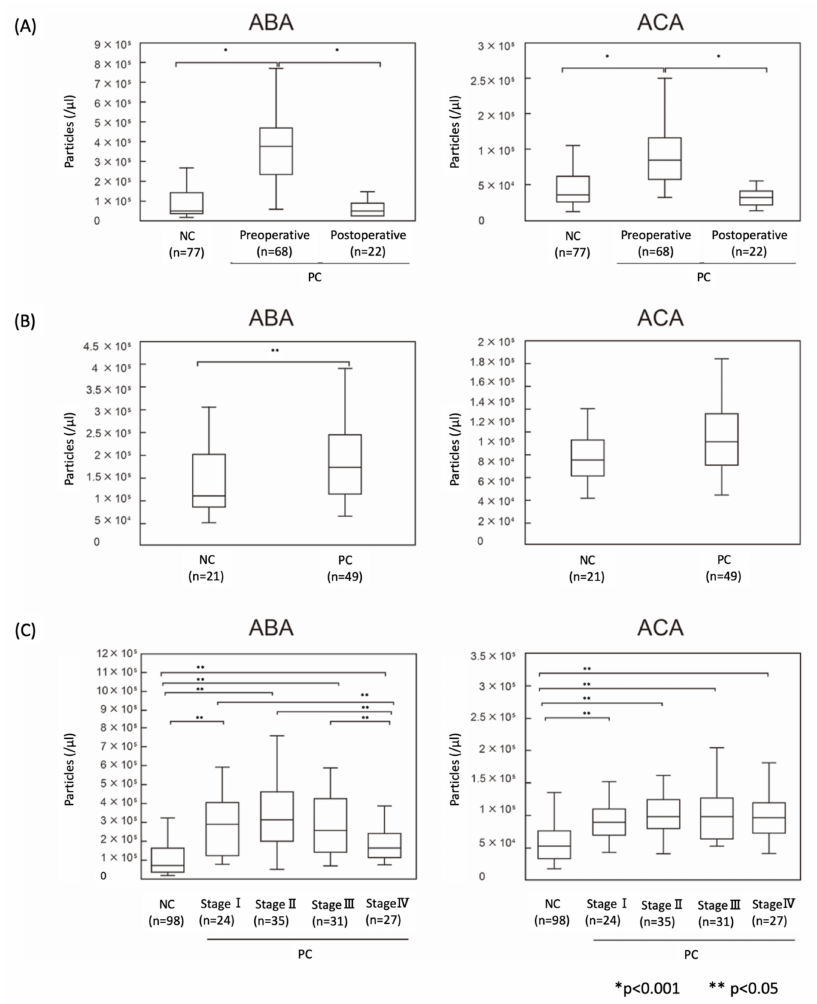
Figure 5. Quantification of ABA- and ACA-positive EVs in PC sera. Patient sera were analyzed using ABA- or ACA-coated discs and anti-CD9 Ab-conjugated beads with ExoCounter. ( A ) Quantification of ABA- and ACA-positive EVs from sera of preoperative and postoperative PC patients and NC (cohort 1). ( B ) Quantification using PC and NC sera obtained from cohort 2. ( C ) Comparison of ABA- and ACA-positive EVs from PC stage I–IV and NC sera in cohorts 1 and 2. Box plot indicates the 25th to 75th percentile. The medians of the samples are represented as the bars. p values were calculated using the Mann–Whitney U-test. * p < 0.05, ** p <